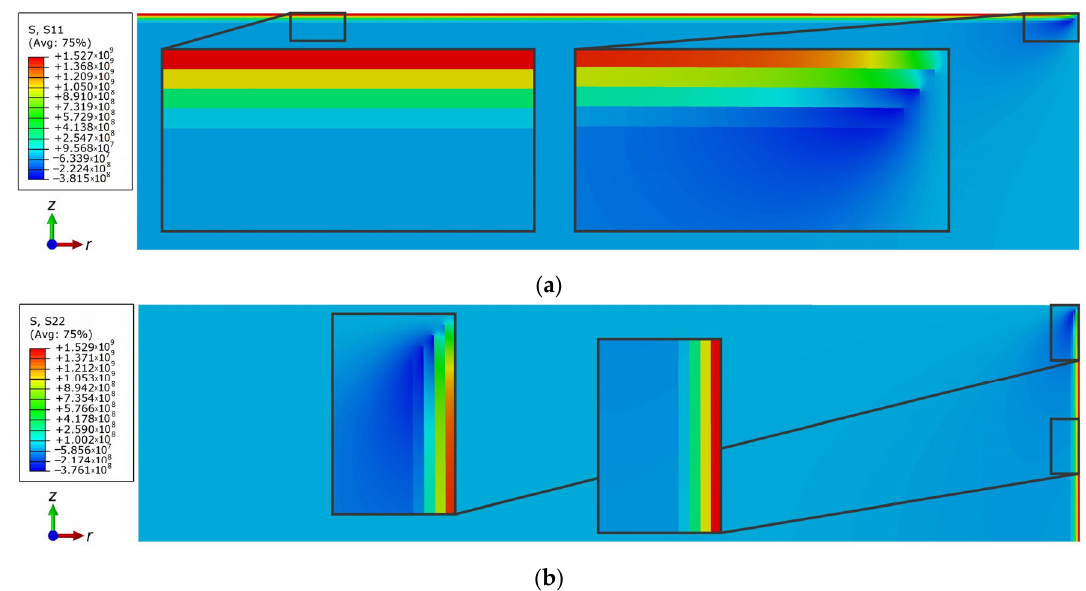
Figure 10. Distributions of the normal stress components: ( a ) Radial stress σ rr ; ( b ) Axial stress σ zz . The maximum positive stresses are observed in the upper layer of the modeled ZrO 2 coating. As in the experiment, the residual stresses change sign from compressive stresses in the substrate (in the bulk of the ZrB 2 –SiC disk) to tensile stresses closer to the surface of the composite sample. This confirms the conclusions about the presence of tensile residual stresses in the coating, made in the experimental part of the work when observing the crack growth in the surface layers during indentation.